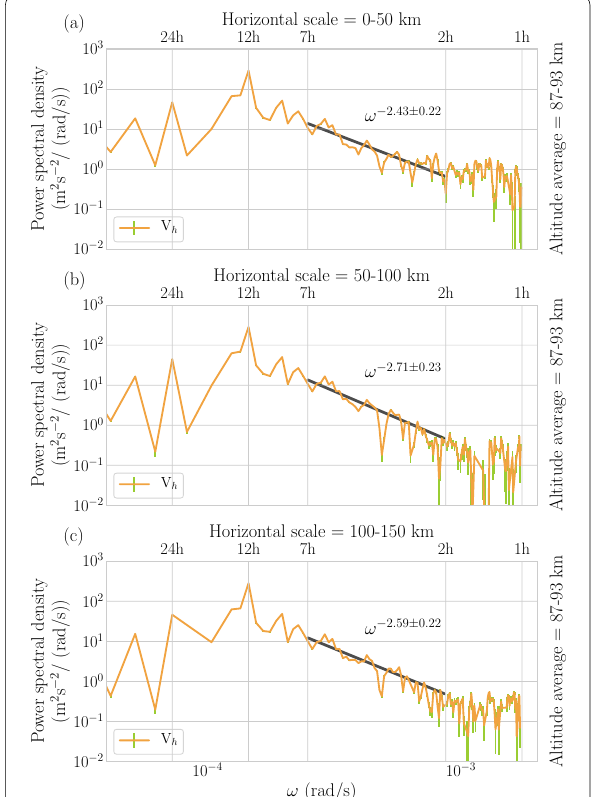
Fig. 7 Plots a – c illustrate the frequency spectra of horizontal Fig. 6 Plots a – c show the horizontal frequency spectra estimated velocities obtained from the WCFI and MWE methods around three by WCFI method using three different horizontal scales: 0–50 altitudes, i.e., 84( 3), 90( 3), 96( 3) km. The solid black line in plots km, 50–100 km and 100–150 km, respectively. The orange lines ± ± ± illustrate the spectra obtained from the WCFI method, and the blue correspond to the frequency spectra and, the light green vertical lines dashed lines show the MWE spectra. The solid and transparent show the standard error of spectra estimation on the spectra. All the shades of black lines and blue lines in the plots show power-law spectra were estimated around 90 ( 3) km altitude. The solid black slopes of the WCFI and MWE spectra, respectively. Slope values with ± line on top of the spectra illustrates a power-law fit between (2 π /7 standard error are inscribed in the plots in black and blue fonts, which h) and (2 π /2 h). The slope values with standard error are inscribed in corresponds to WCFI and MWE spectra, each plot